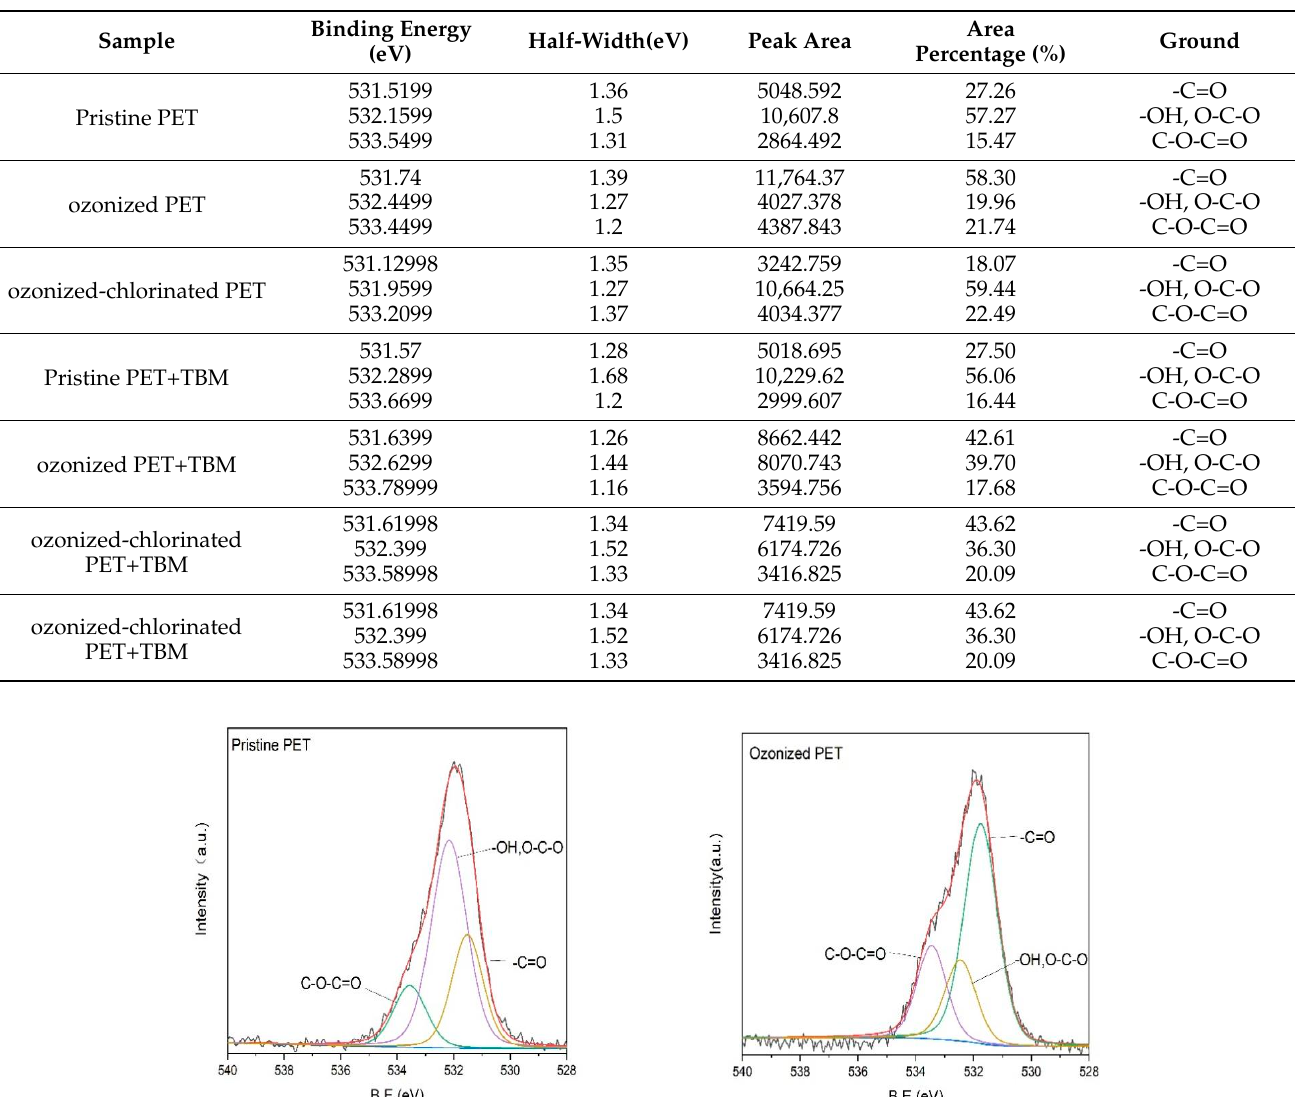
Table 1. The result of XPS of pristine PET and oxidized PETs.